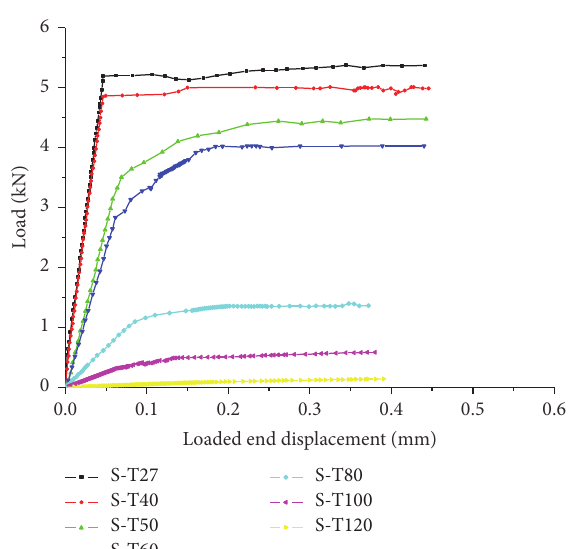
Figure 5: Load-displacement